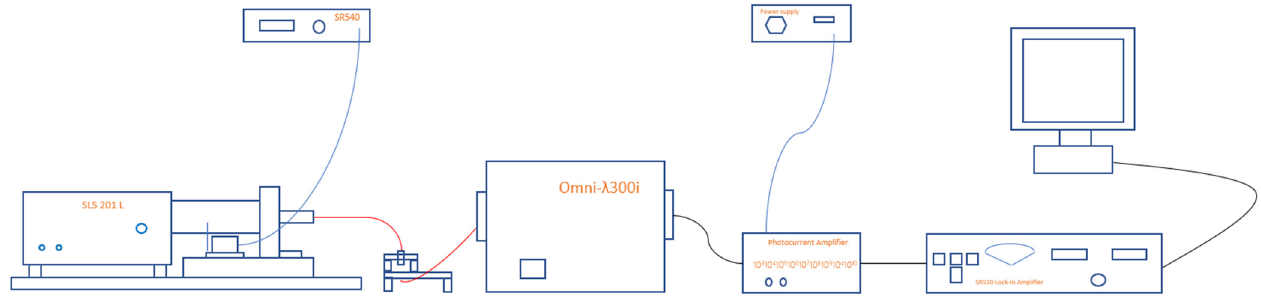
Figure 2. Schematic diagram of the hardware structure of the infrared optical monitor system.